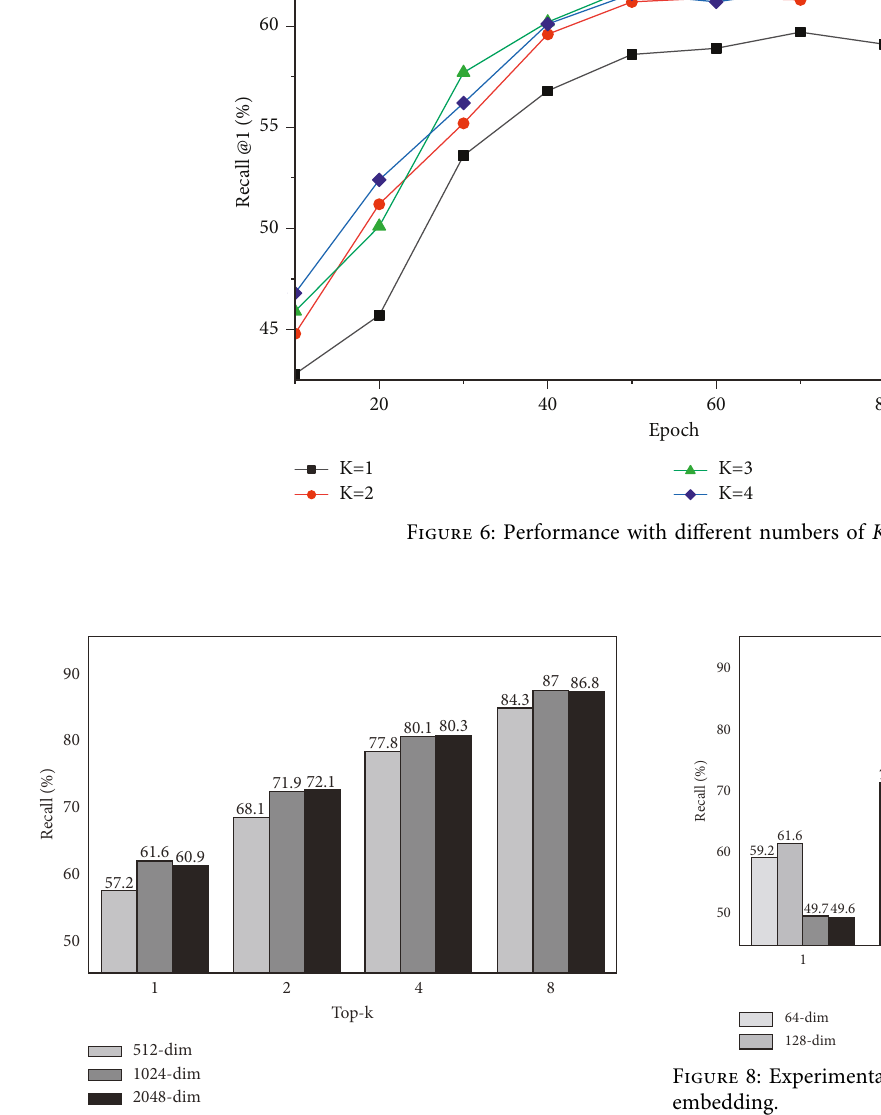
Figure 7: Experimental results on different dimensions of cross- modal embedding.